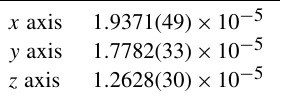
Table 4. Parameter a S experimentally determined by 3D Hall sen- sor measurements with double standard uncertainty, e.g., last two